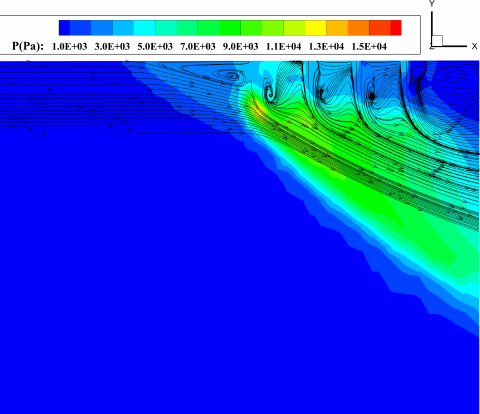
Figure 11. Spanwise 0.116 Section Plane Pressure Contour and Streamlines from Case